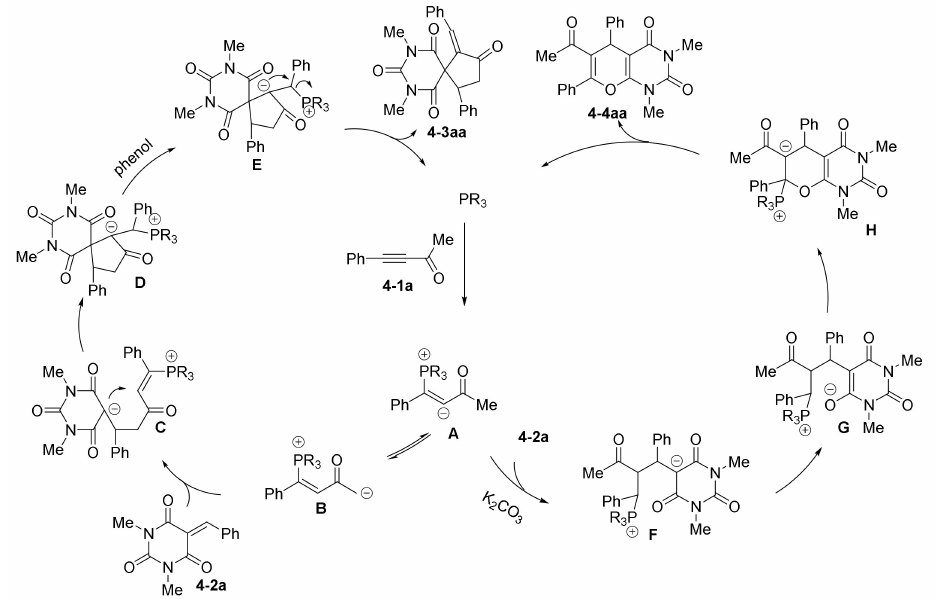
Scheme 9. Plausible mechanism for phosphine-catalyzed [3+2] and [4+2] annulation reactions. Christmann and colleagues described the catalysis of the bromocyclization/regiodiver- gent reaction of alkenes ( 5-1a-l ) by chiral phosphoric acids to afford both bromohydrin products in excellent yields and with good enantioselectivities (Scheme 10) [71]. More specifically, the chiral phosphoric acids containing 9-anthracenyl ( 5-C5 ) delivered the best results to produce both the regioisomers 5-2 and 5-3 in excellent yields with enantios- electivities. A cinnamyl ester containing an EWG or EDG in the para or meta position produced the two corresponding isomers in excellent yields with high enantioselectivities. Derivatives with sterically bulky groups such as phenyl, and 1-naphthyl derivatives at the ortho position smoothly reacted to afford the expected isomers in excellent yields to- gether with good enantioselectivities. Various homoallylic esters ( 5-1m-o ) were utilized to produce 5-2m-o with excellent enantioselectivities, whereas 5-3m-o was obtained with lower enantioselectivities.